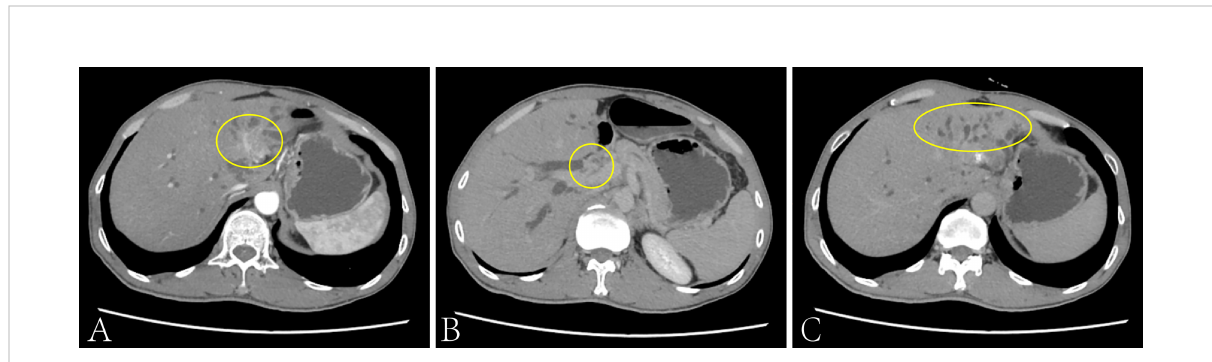
FIGURE 1 The CT scan of the patient ’ s liver on Dec. 2020. The main metastatic lesion (3.4 × 2.6cm) in the left and caudate lobe of the liver (A) , the metastatic nodule (1.5 × 1.1cm) in the hepatic portal (B) and the localized common bile duct compression (C)